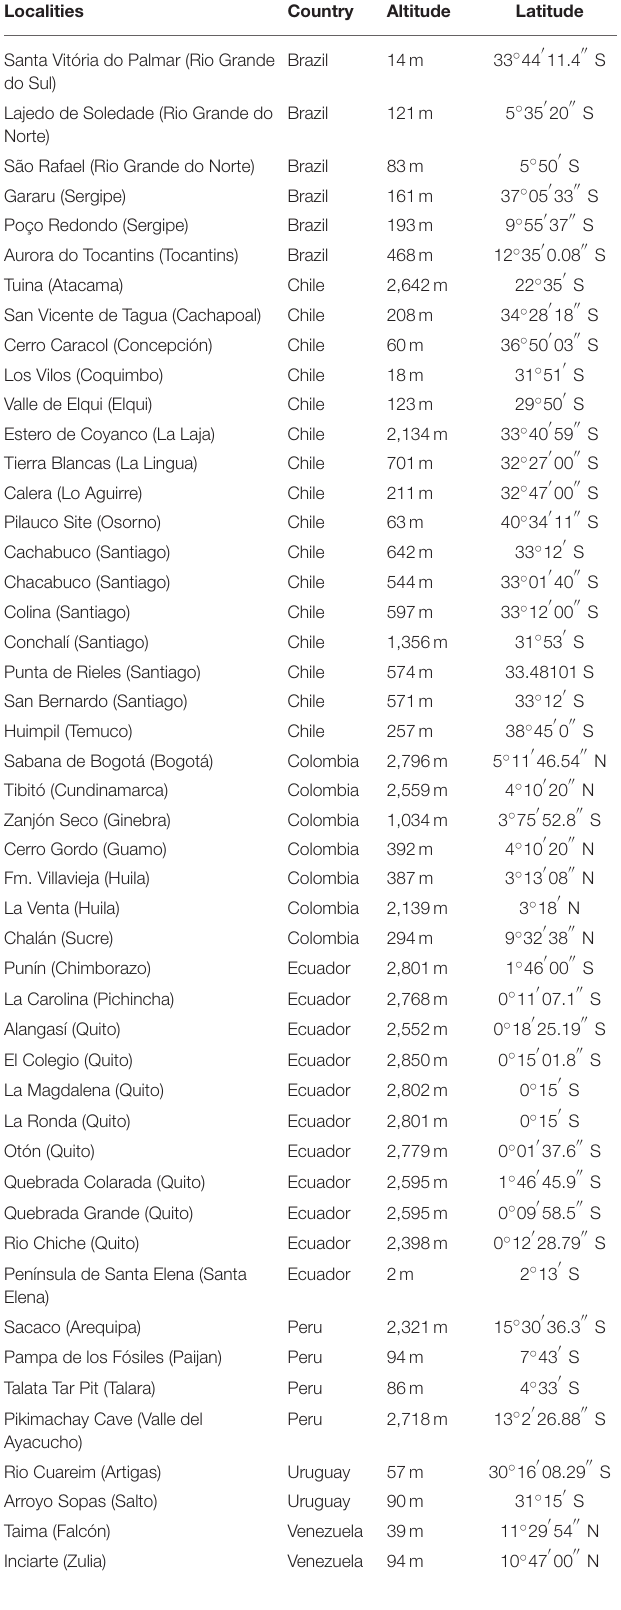
could gradually change into steeper ones. If the distinctions between adjacent populations within the cline become